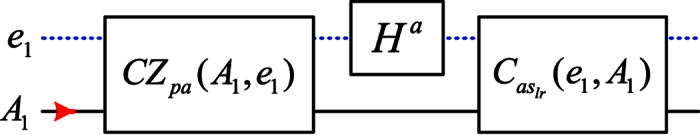
Hybrid CNOT gate on different DoFs of one photon.e1 denotes an auxiliary NV center in the NV-cavity NV1. The subcircuits CZpa and Cas are shown in the Fig. 3.